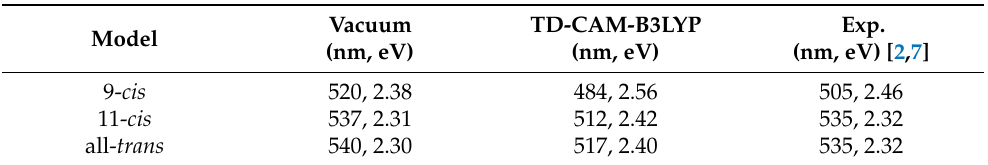
Table 1. Absorption maximum of each isomer in vacuum and in the protein modeled using electro- static embedding, as well as the experimental values